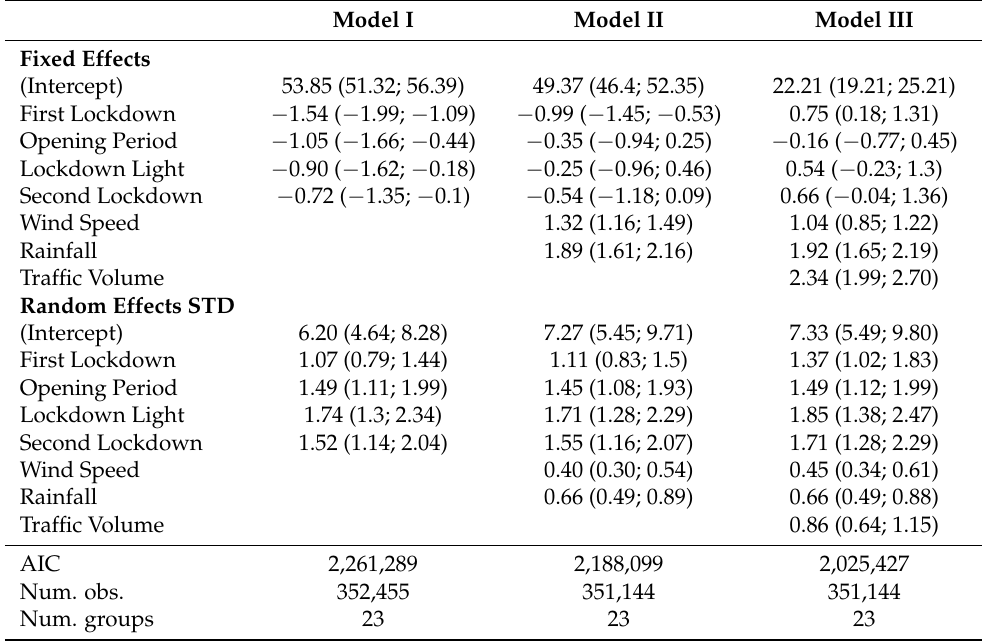
Table 2. Results of the linear mixed model analyses. Depicted are the crude and adjusted effect estimates with their corresponding 95% confidence intervals in brackets. Model I: unadjusted (crude), Model II: adjusted for wind speed (in m/s) and rainfall (in mm), Model III: additionally adjusting for traffic volume (log 2 (vehicles/h)). Lower number of observations for Models II and III are explained by some missing hours for wind speed and rain